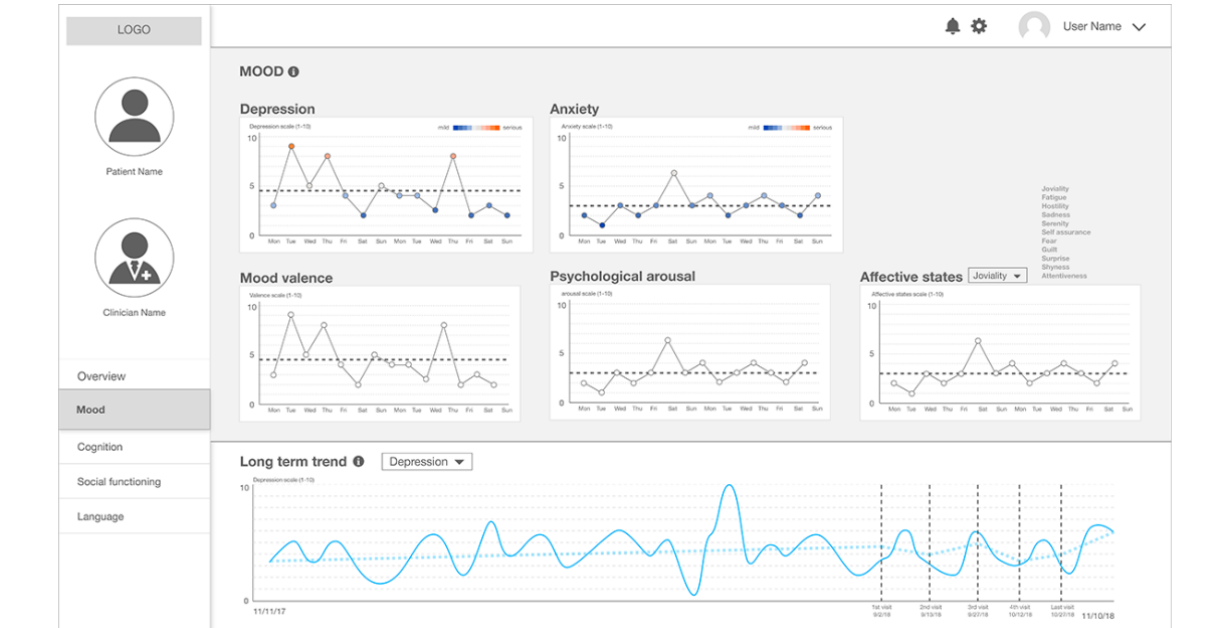
Figure 3. The second prototype: a clinical state and trend visualization interface – "Mood".